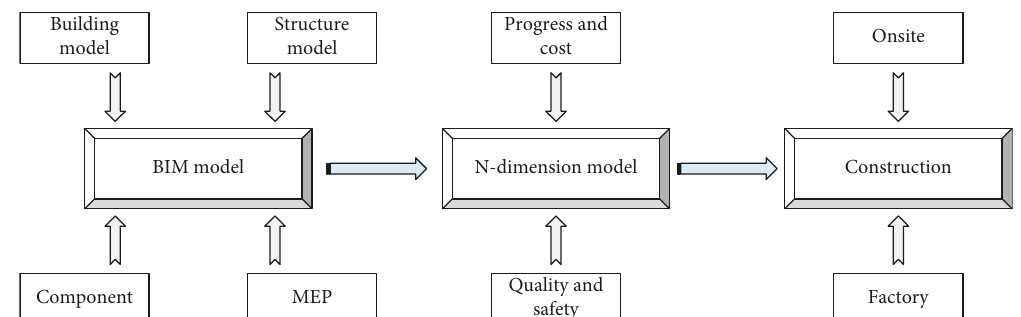
Figure 7: Process of BIM and VR.